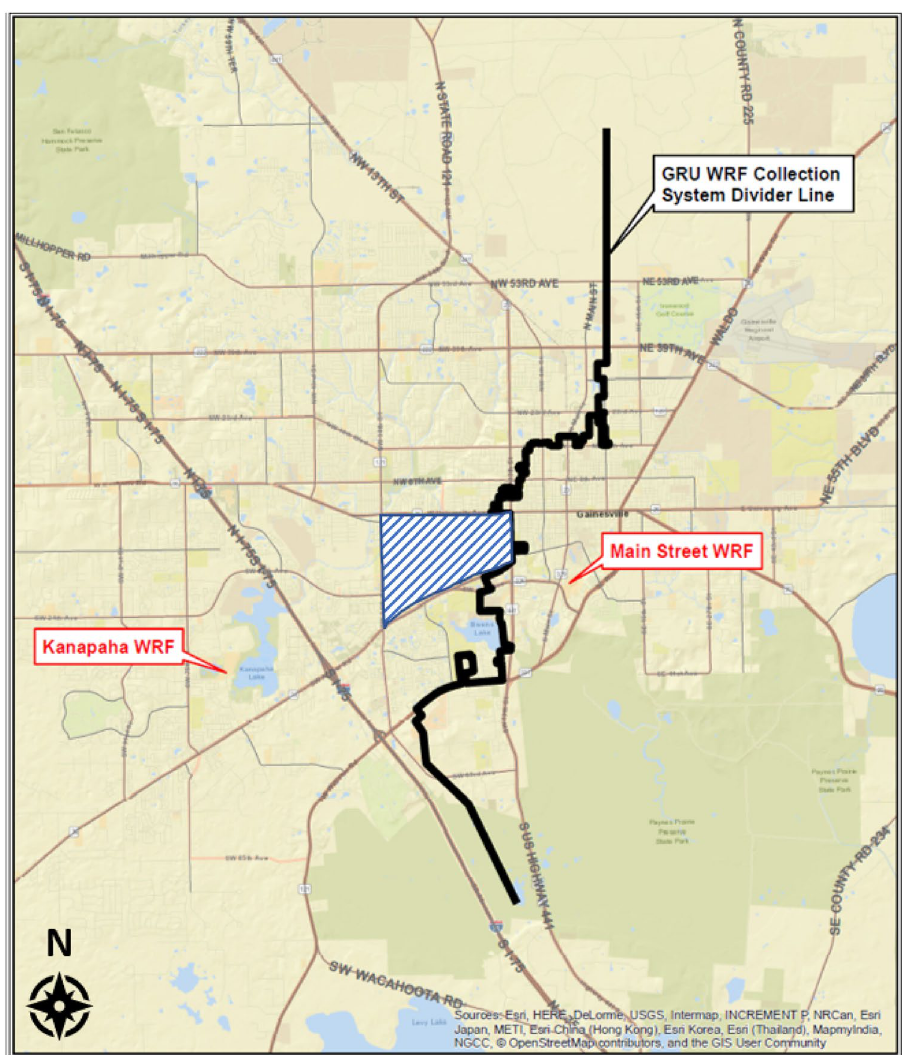
Figure 1. The wastewater service map of Gainesville, FL. The Gainesville Regional Utility (GRU) divider line running through the center of the city separates the service area for the two water reclamation facilities (WRF) that services the east (Main Street WRF) and west (Kanapaha WRF) areas of Gainesville, FL. The shaded blue area in the figure denotes the area of the University of Florida which has an on-campus WRF that independently services the